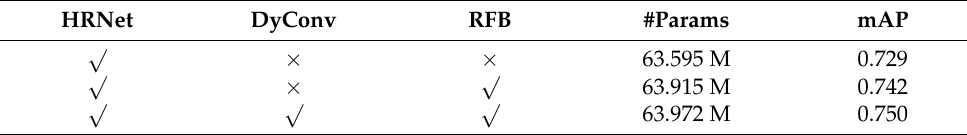
Table 4. Comparison of experimental results under different methods.